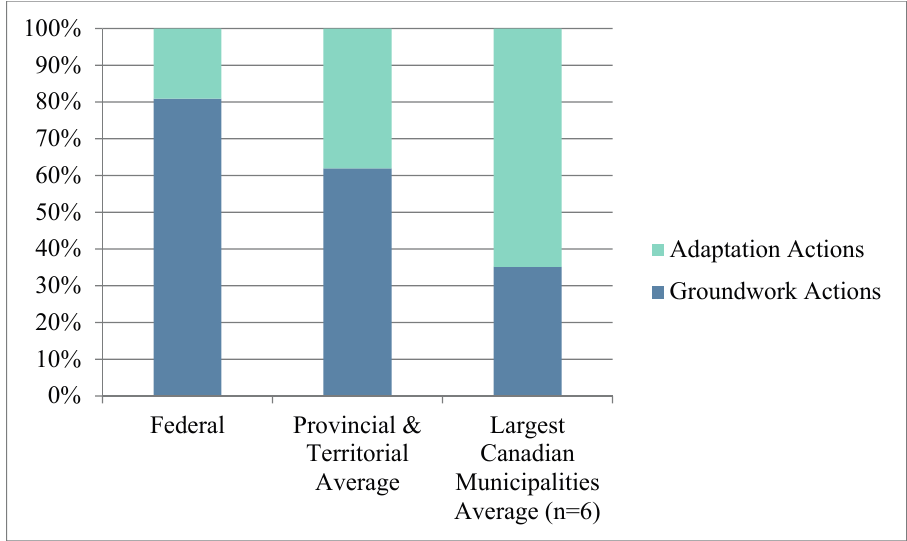
Figure 8. Average percentage of groundwork initiatives and adaptation actions by